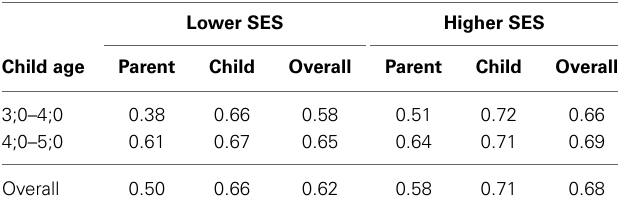
Table 3 | Proportion of letter names that occurred in sequences in analysis 3, by SES, speaker, and child age.